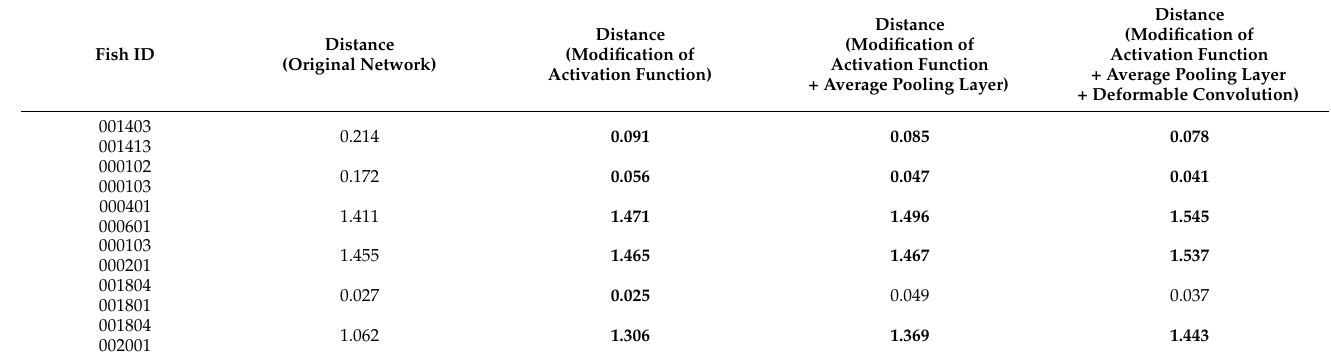
Table 2. The effects of different stages of improvement on the recognition effect.